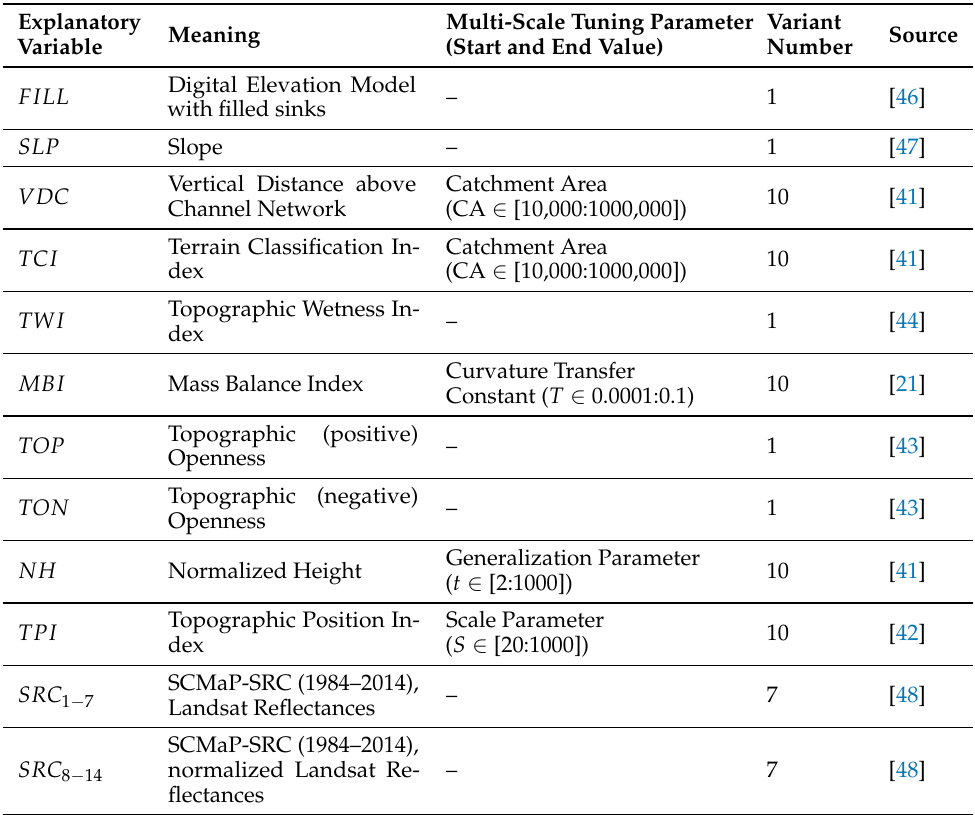
Table 1. Explanatory variables for the SOC content prediction: terrain attribute variants and SCMaP- SCR bands ( SM 1 − ... : definitions of terrain attribute variants and tuning parameters see function fNumP() and R function collection (https://github.com/FLFgit/ScaleP/blob/master/callScaleP.R; accessed on 13 March